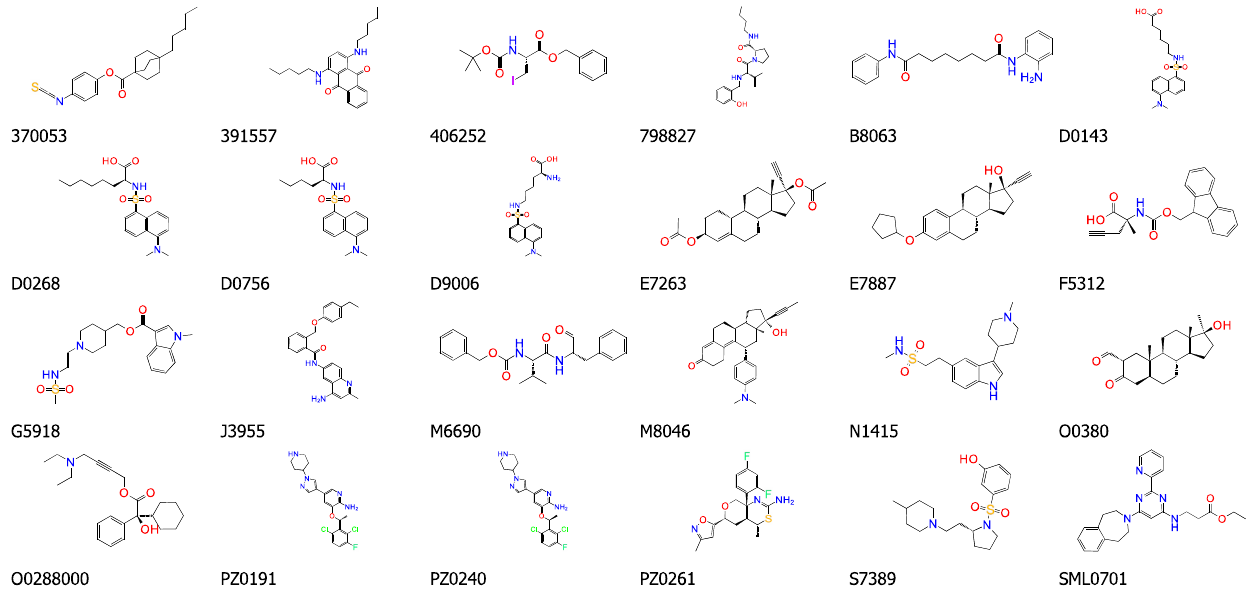
Figure 7. Representation of the chemical structure of the 24 small molecules selected as potential Cdc25s modulators and identified by the correlation between protein expression pattern (EPs) and antiproliferative activity (GI 50 s) data.